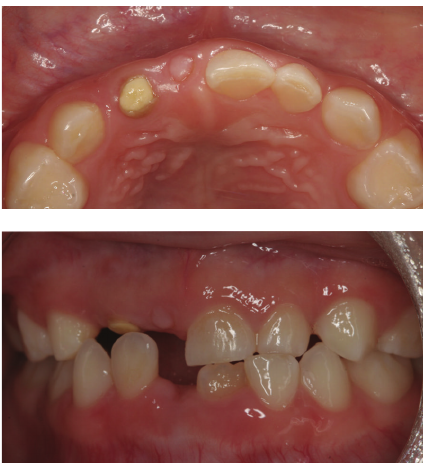
Figure 6: Periapical radiograph at age 9 years and 2 months (case 2). There is no evidence of eruption